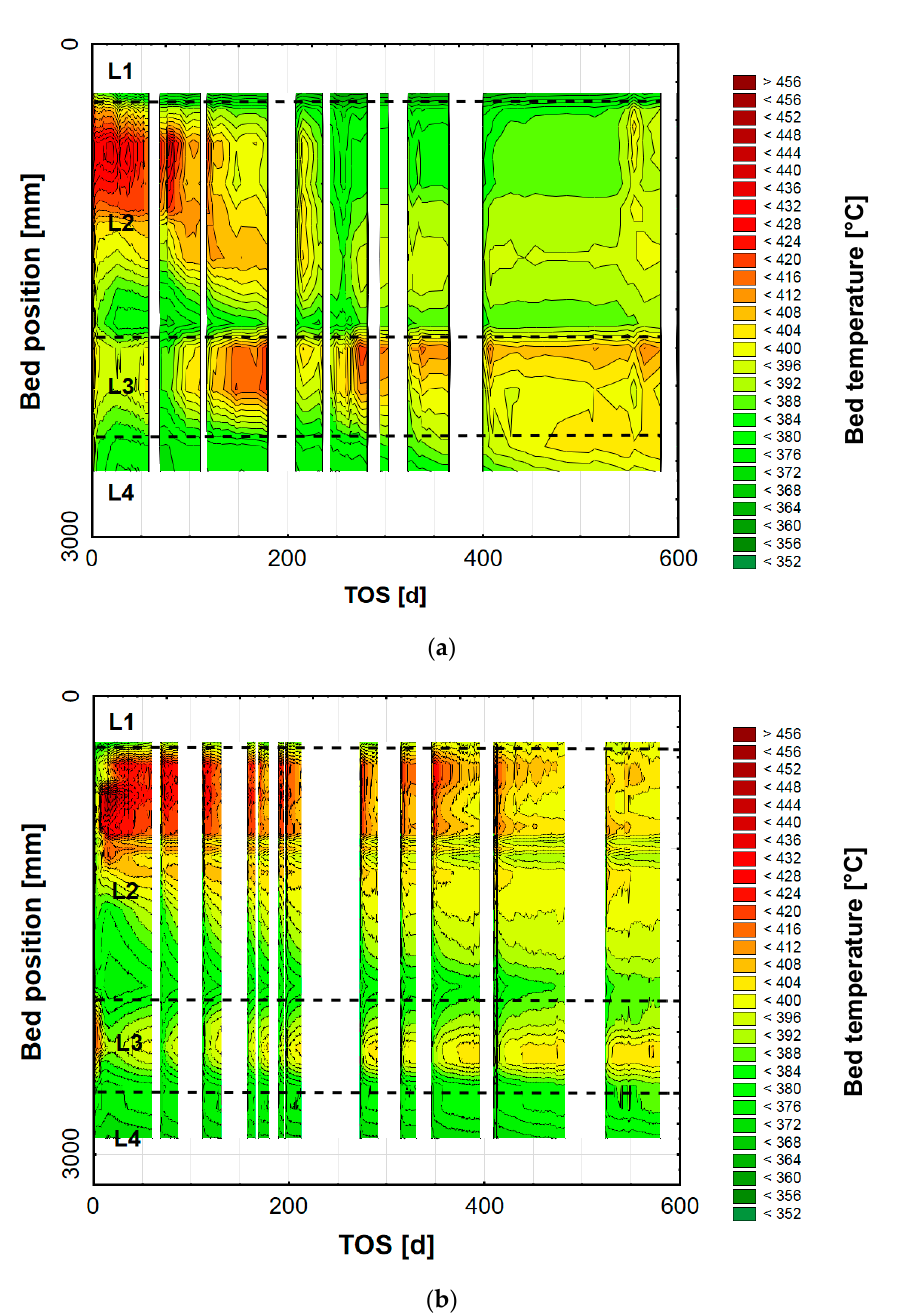
Figure 4. Evolution of catalyst bed temperature as determined by single point thermocouples vs. TOS: ( a ) Investigated reactor; ( b ) commercial reference reactor. The reactor inlet is at position 0 mm and the catalyst layers are labelled according to their loading position. White, vertical areas in the contour plot indicate plant shutdowns.